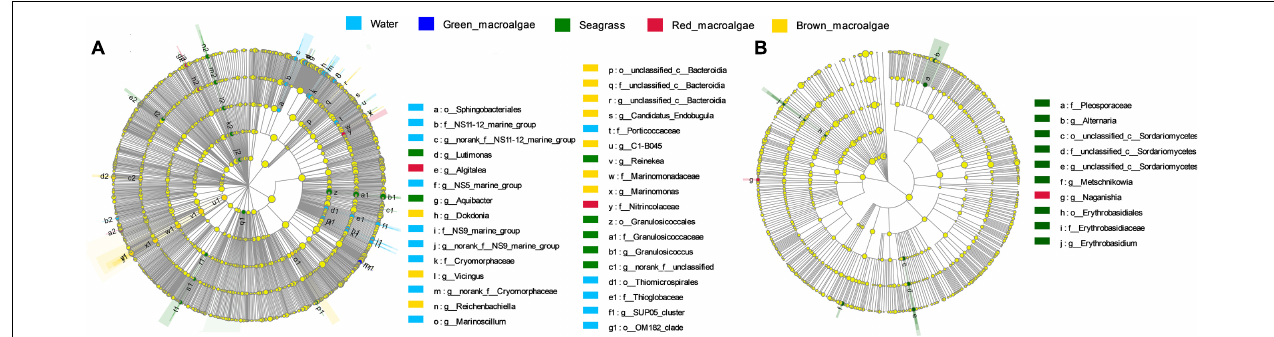
FIGURE 6 | Biomarker analysis of the seawater, green macroalgae, red macroalgae, brown macroalgae, and seagrasses. Cladogram showing the phylogenetic structures of the microbiota. In the branching diagram of their evolution, the circles that radiate from inside to outside represent taxonomic levels from phylum to genus, and each small circle represents an individual taxon. The diameter of the circles is proportional to the relative abundance. Species that are not significantly different are uniformly colored yellow. (A,B) Refer to the bacterial samples and the fungal samples, respectively.